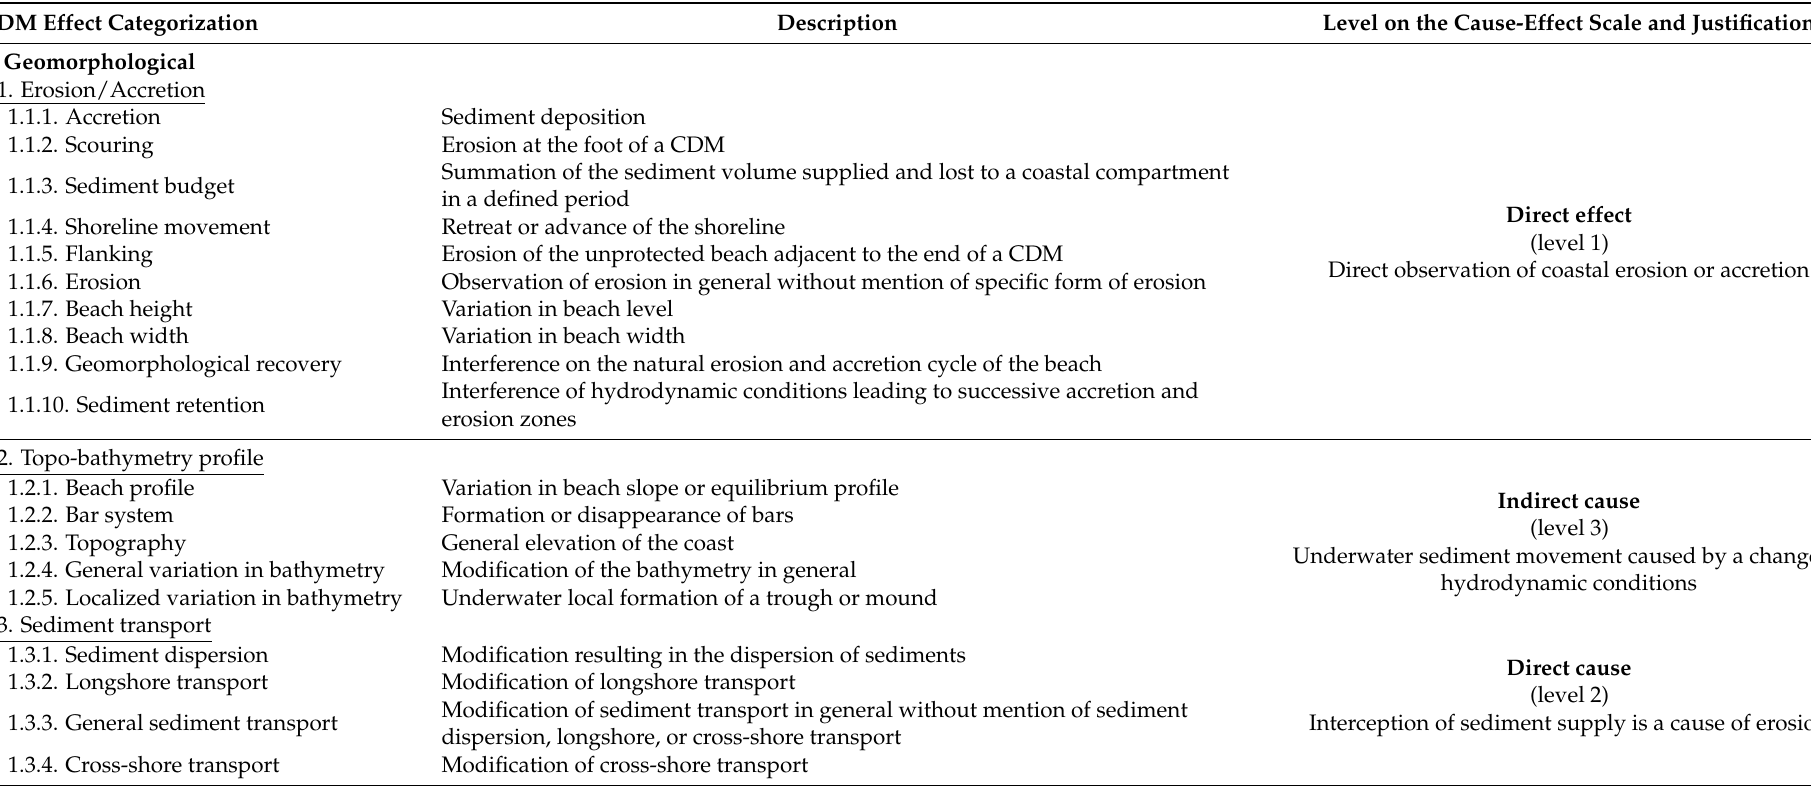
Table 5. Categorization system ( category , type, subtype) and prioritization of CDM